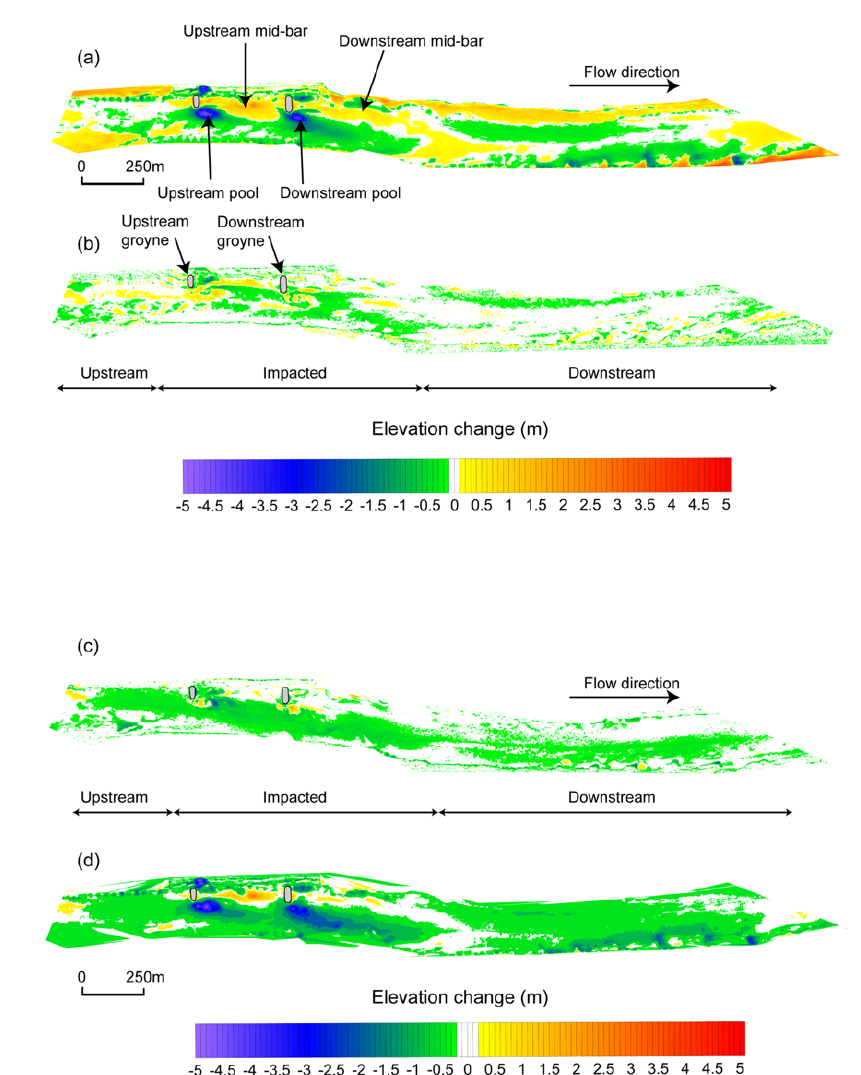
Figure 5. Morphological changes in the channel during period 1 (P1); ( a ), period 2 (P2); ( b ), period 3 (P3); ( c ) and the whole monitoring period ( d ). Grey areas correspond to the two artificial groynes implemented to facilitate bank